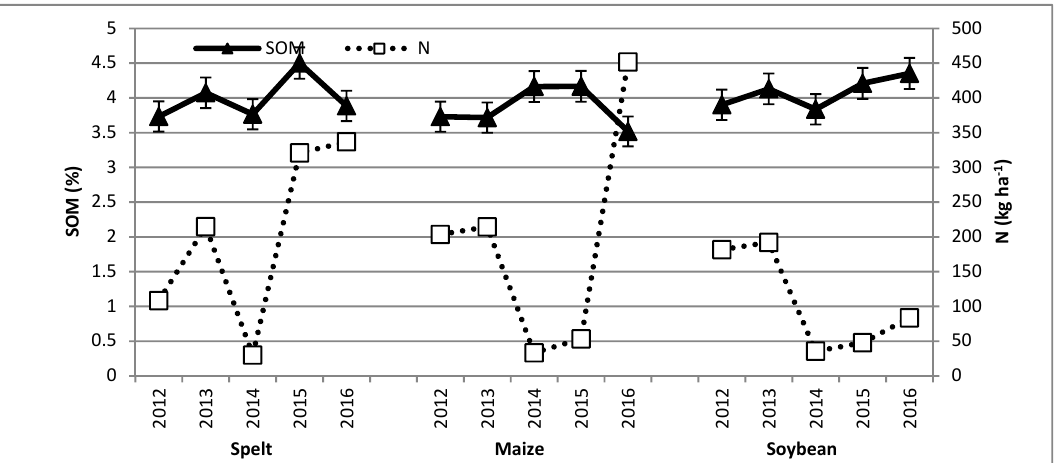
Figure 1. The status of soil organic matter (SOM) and available N in soil across seasons, under organic production (bars represent SD values).